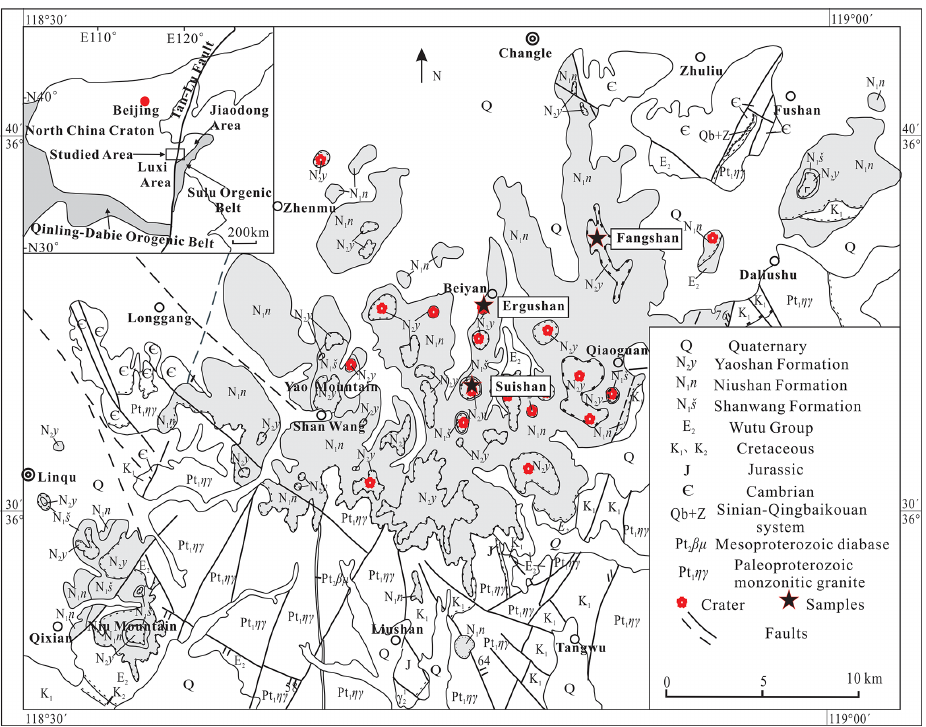
Figure 1. Geological sketch map of the study area (modified after Kong et al., 2017), indicating the sampling localities Fangshan, Ergushan and